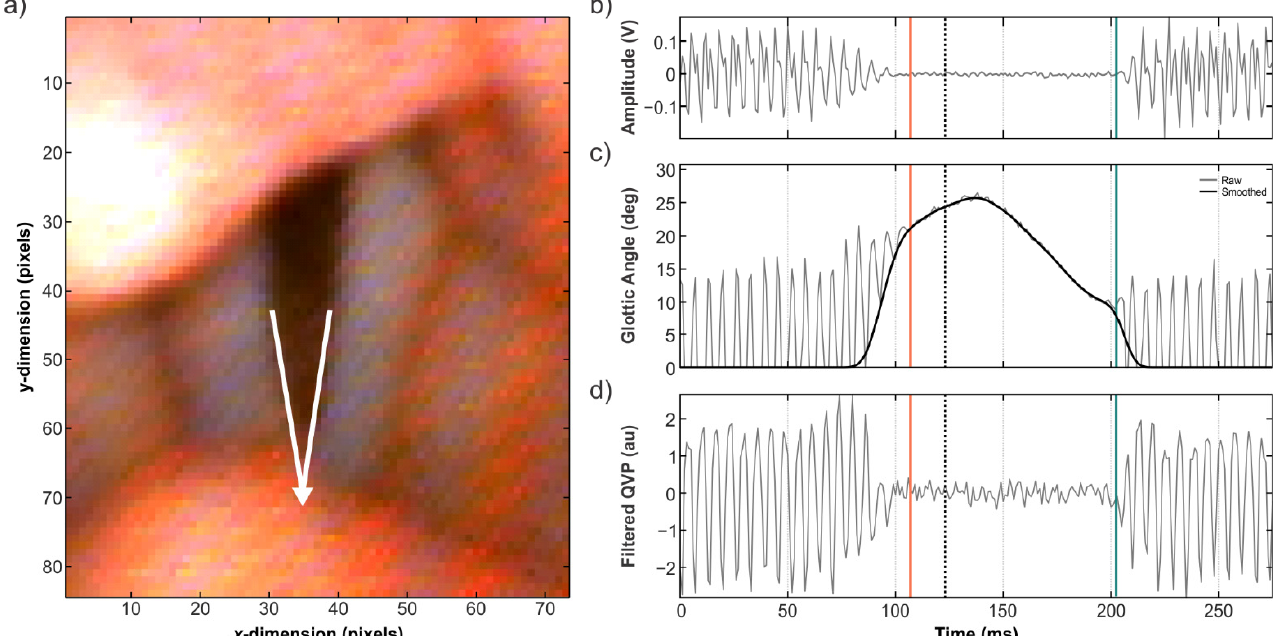
Figure 2. ( a ) View of the vocal folds under flexible nasendoscopy, with the glottic angle marked from the anterior commissure to the vocal processes, ( b ) acoustic signal, ( c ) raw glottic angle waveform (gray) with smoothed data overlay (black), and ( d ) Filtered quick vibratory profile (QVP). The black dotted line in ( b – d ) indicates the current video frame shown in ( a ). The time of voicing offset (orange solid line) and time of voicing onset (teal solid line) are indicated in ( b – d ).